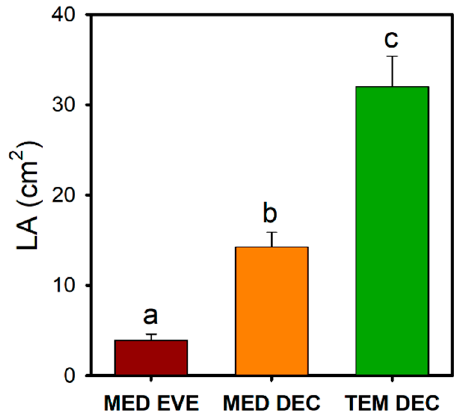
Figure 2. Leaf area (LA, cm 2 ) of Mediterranean evergreen (MED EVE), Mediterranean deciduous (MED DEC), and Temperate deciduous (TEM DEC) oaks. Data are mean ± s.e. of five species. Different letters indicate statistically significant differences (Tukey test, p < 0.05) (Supplementary Materials).